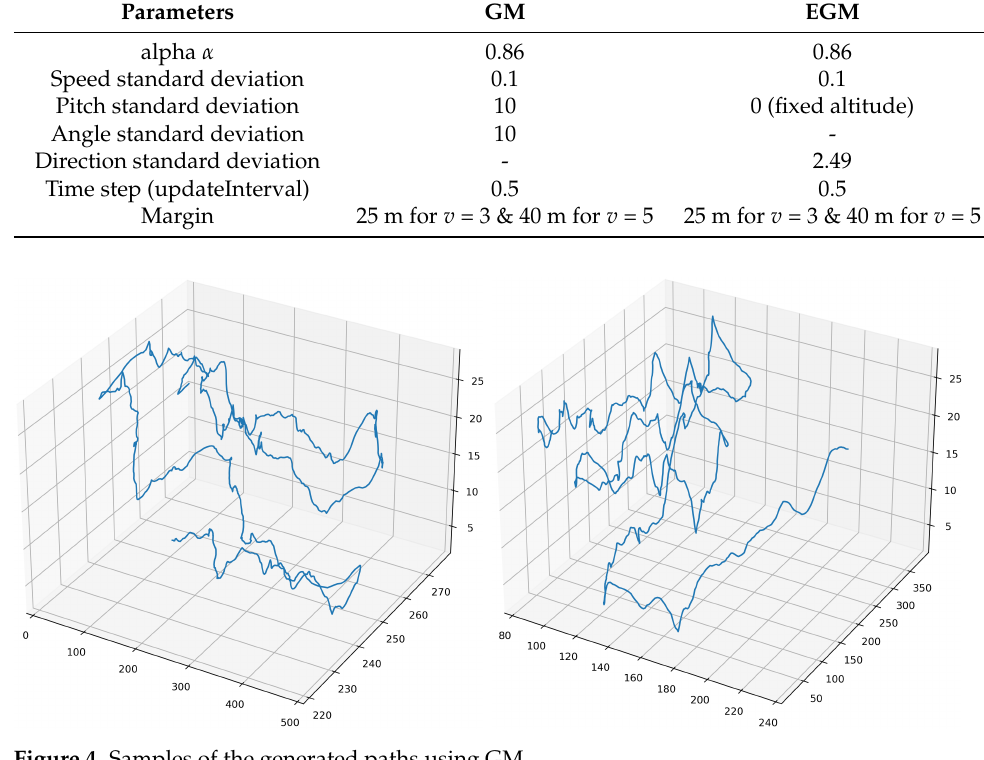
Figure 4. Samples of the generated paths using GM.